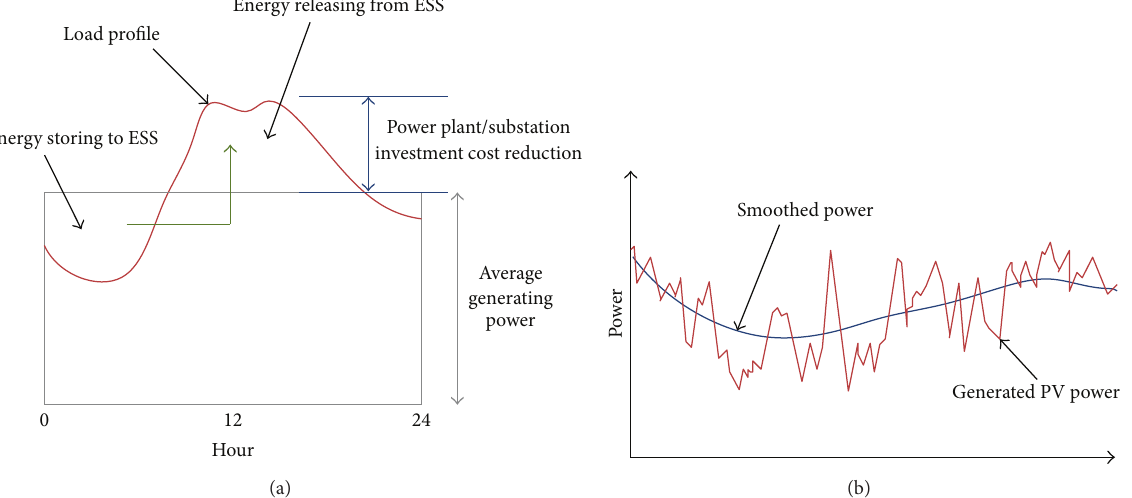
Figure 1: Power curves of ESS and PV systems; (a) power curves of ESS; (b) power curves of PV